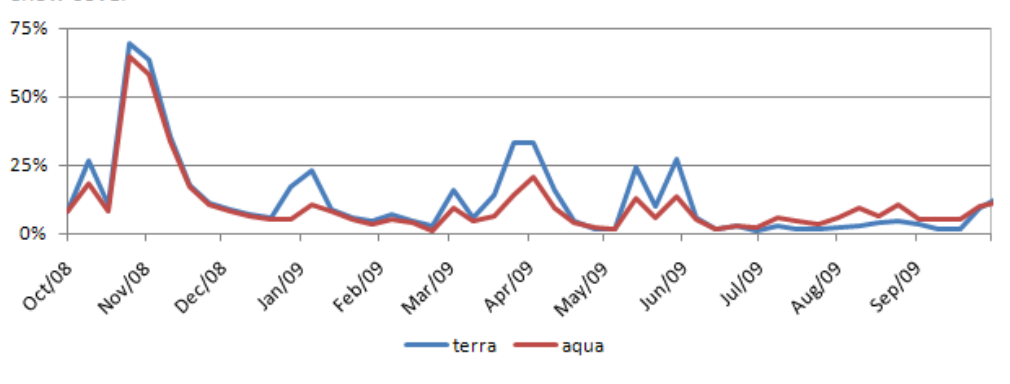
Figure 2. Comparison of snow cover percentage of the whole square subset area of Nam Co Basin from Terra (morning overpass) and Aqua (afternoon overpass) data for the year